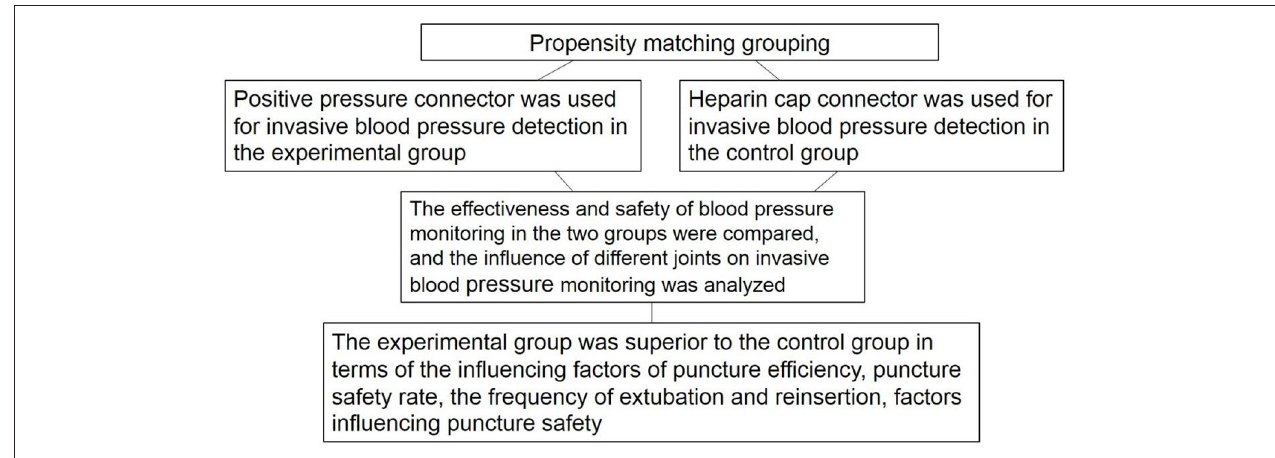
FIGURE 1 | Propensity matching grouping.